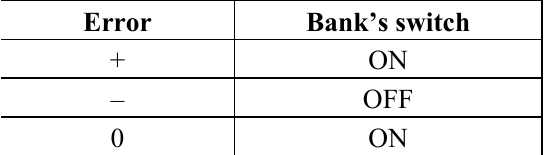
Table 2. Switch’s states based on the power